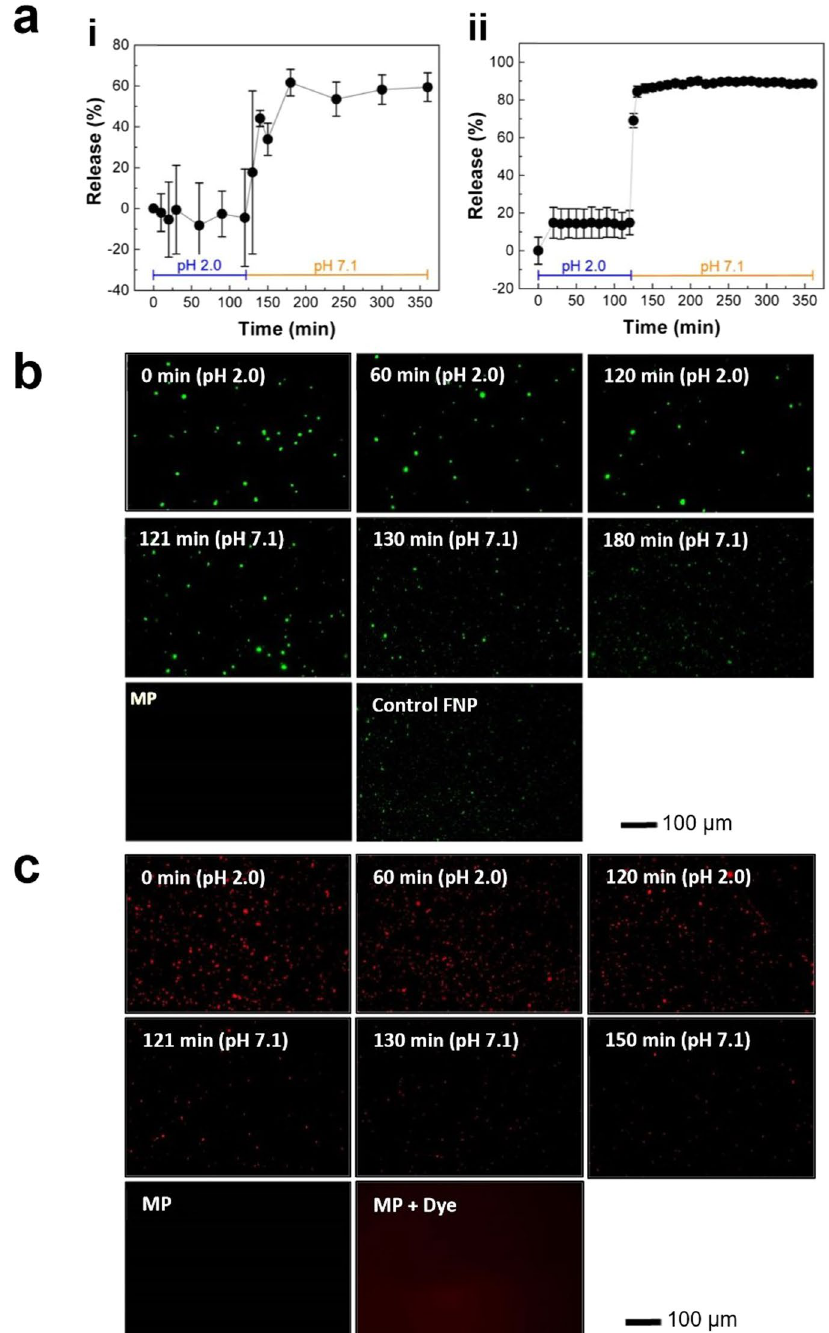
Figure 3. Release of ingredients from MPs in digestive conditions. ( a ) Time dependent release profile of encapsulated 100 nm FNPs (i) and SRB (ii) from MPs subjected to simulated GI tract environment (stomach: 2-hr incubation at pH 2.0 and 37 °C, and intestine: 4-hr incubation at pH 7.1 and 37 °C). ( b ), ( c ) Representative fluorescence micrographs of ( b ) FNP- and ( c ) SRB-encapsulating MPs after incubation at simulated gastric and intestinal conditions. As a control, fluorescent micrographs of MPs without FNP and SRB are shown for